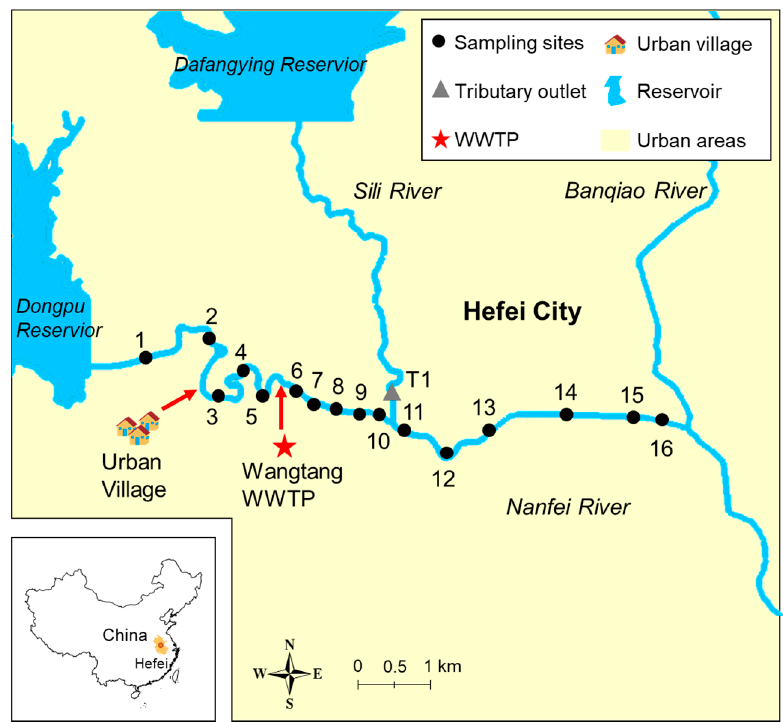
Figure 1. Nanfei River system, land use, sampling sites in Hefei City, China.